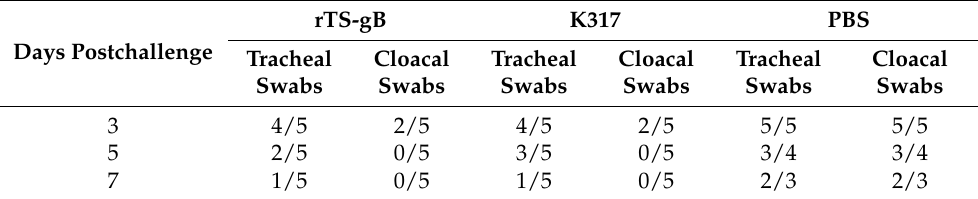
Table 2. Viral shedding in vaccinated chickens after virulent ILTV challenge.